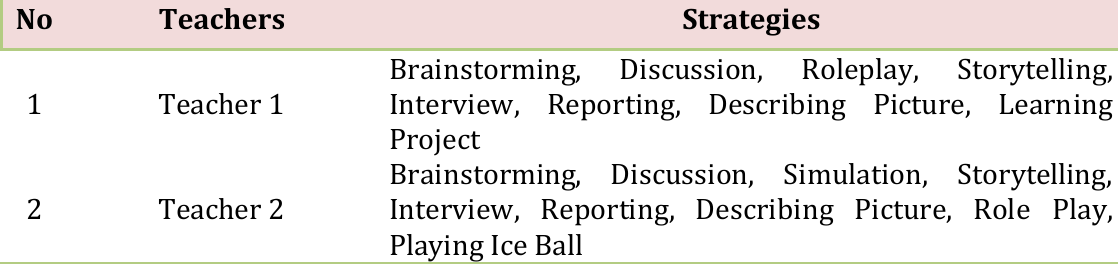
Table 4.1 Teachers' Strategies in Teaching